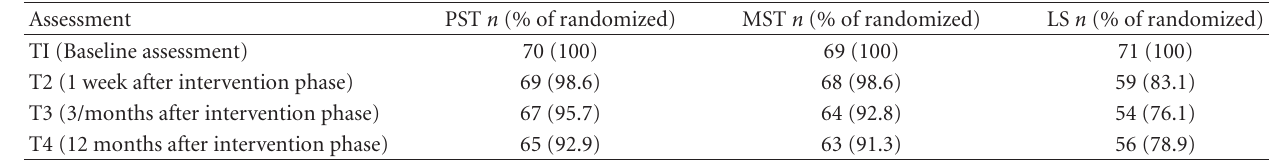
Table 2: Assessments attended across the course of the